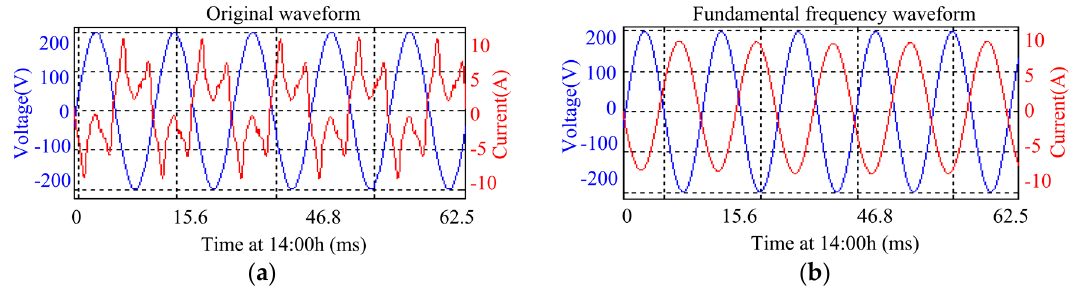
Figure 11. Secondary board SB3.1.1 voltage and current signals at a time when severe stationary disturbances are present: ( a ) original signals; and ( b ) filtered signals around the fundamental frequency.